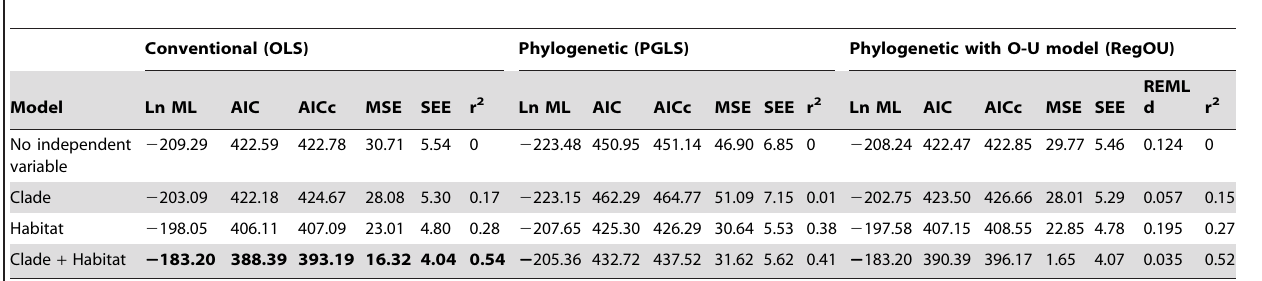
Table 1. Table of alternate regression models for predicting Hct in snakes.